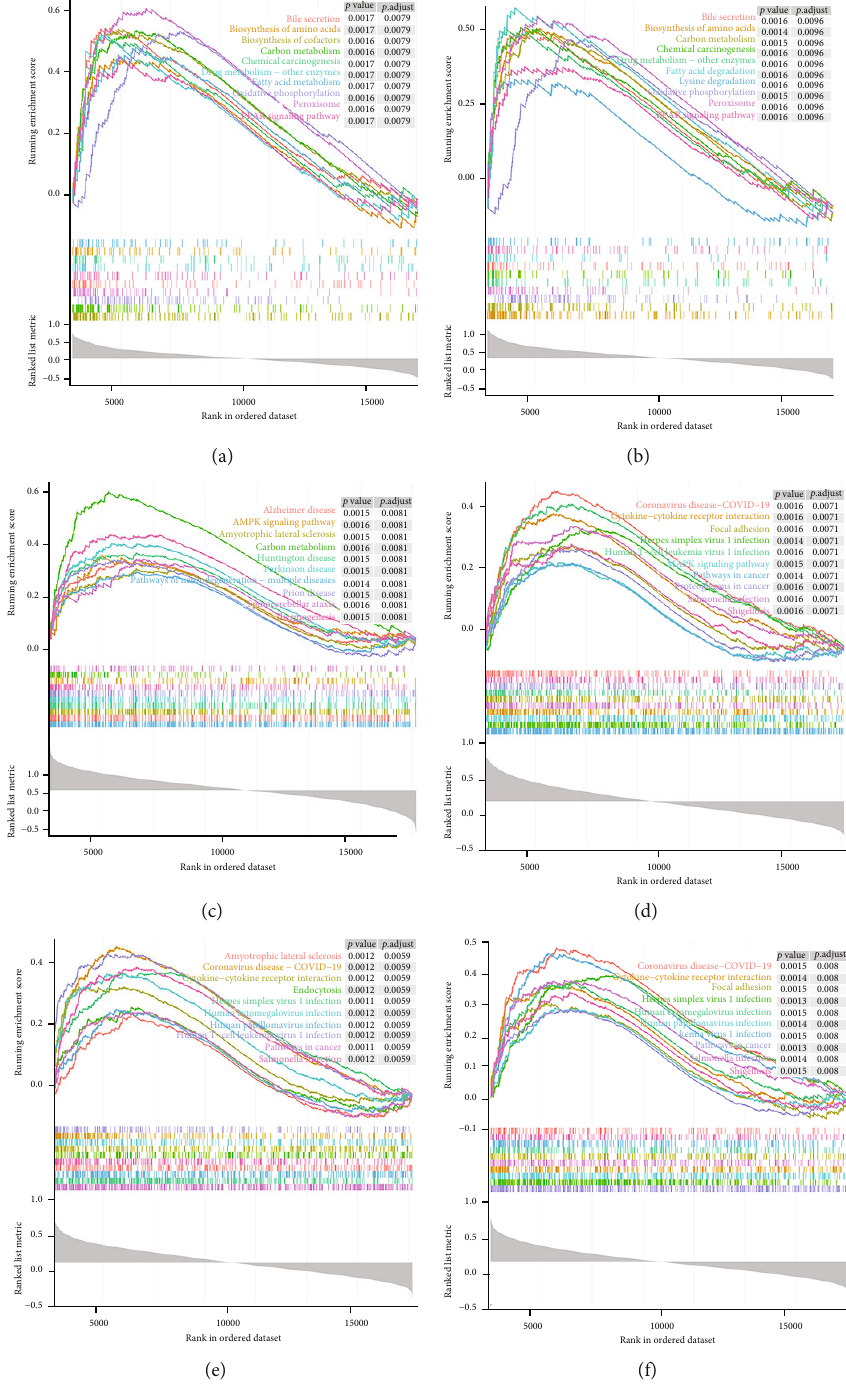
Figure 4: Pathway enrichment analysis of diagnostic genes. A single-gene GSEA-KEGG analysis in the GSE76882 dataset was performed to explore the potential pathways of the six diagnostic genes. (a) ANGPTL3 , (b) APOH , (c) EGF , (d) FCGR2B , (e) HLA-DQA2 , and (f) LTF